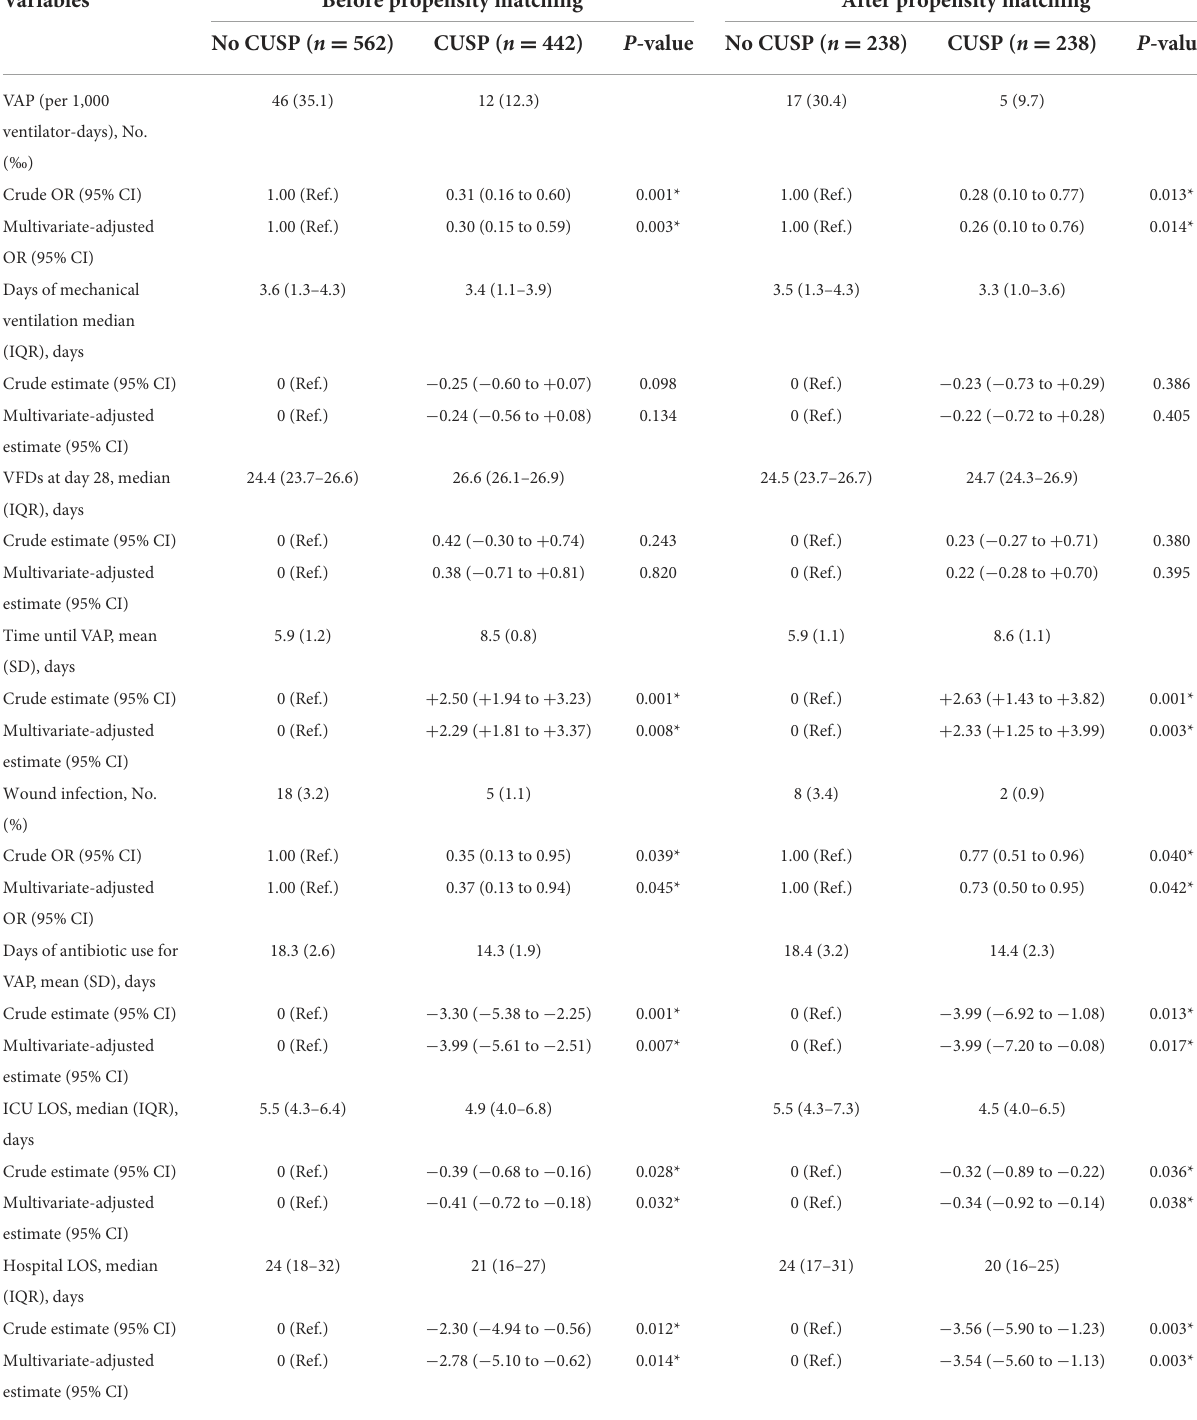
TABLE 4 Logistic regression or linear regression analysis for outcomes based on the initiation of CUSP in the TICU setting. Variables Before propensity matching After propensity matching No CUSP ( n = 562) CUSP ( n = 442) P -value No CUSP ( n = 238) CUSP ( n = 238) P